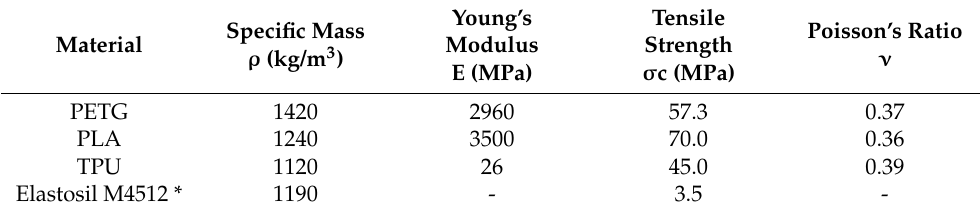
Table 1. Properties of the material used for additive manufacturing.